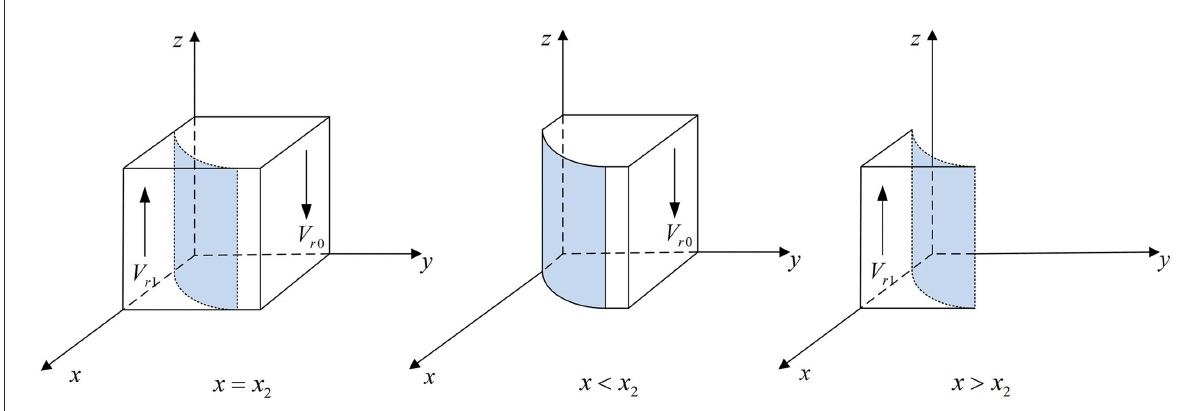
FIGURE4 Phase diagram of medical institutions’ strategic choice. Figure is the phase diagram that shows the evolutionary trend of medical institutions’ strategy obtained by calculating the response function of the probability of medical institutions choosing the “inspection” strategy.